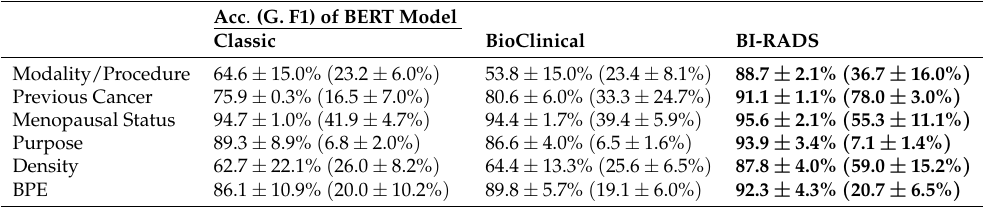
Table 4. Results of 5-fold cross validation field extraction without section segmentation, evaluated with average accuracy with standard deviation (Std.Dev.) and average G.F1 with standard deviation (Std.Dev.) across all 5